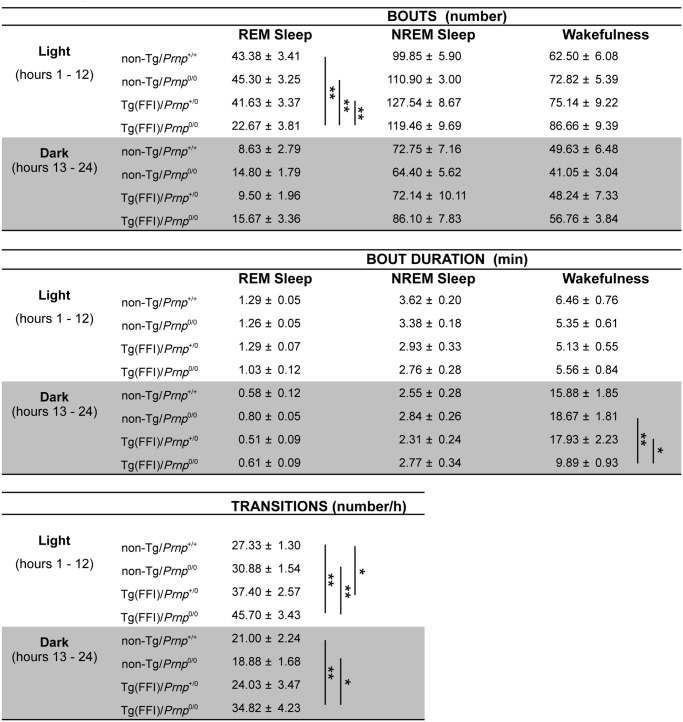
Sleep architecture.Values are the mean ± SEM of 8 non-Tg/Prnp
+/+, 10 non-Tg/Prnp
0/0 mice, 8 Tg(FFI-26)/Prnp
+/0 mice and 9 Tg(FFI-26)/Prnp
0/0 mice. The grey areas indicate the dark portion of the light-dark cycle. *p ≤ 0.05; **p ≤ 0.01 (mixed model for repeated measures followed by between-strain one-way ANOVA with Bonferroni's correction).